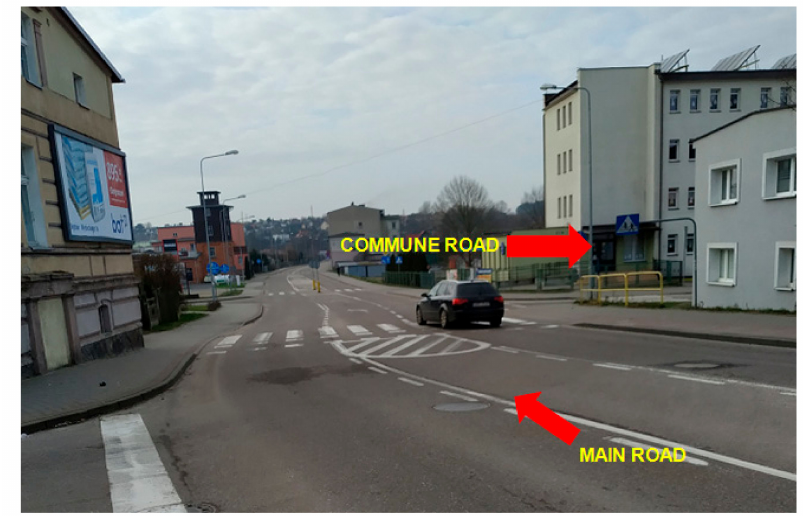
Figure 2. View of the intersection of the main road with the commune road.